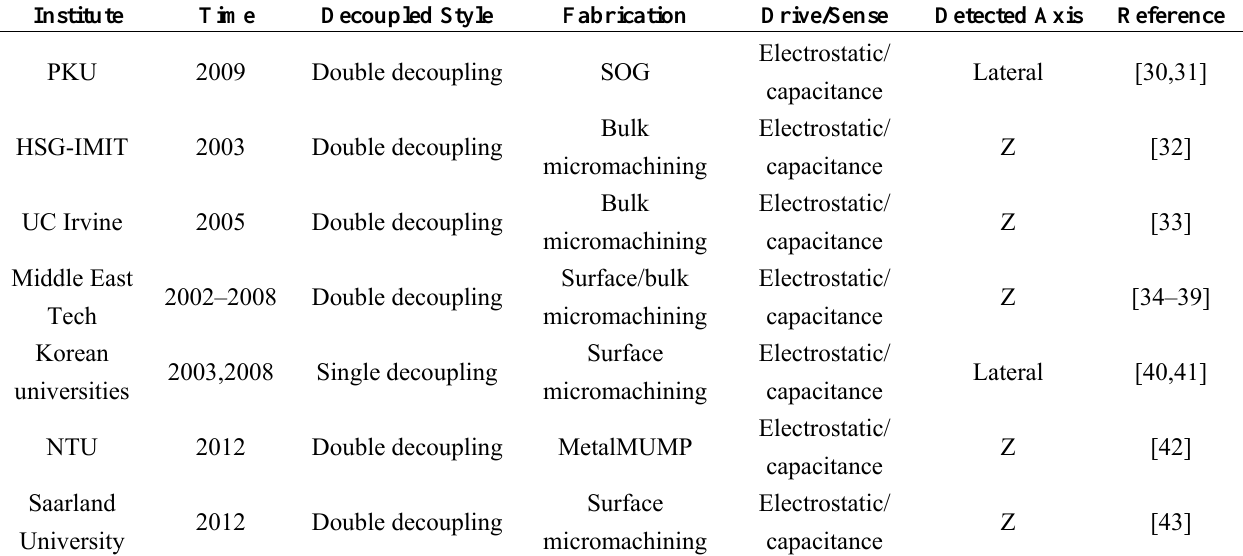
Table 3. The summary of decoupled